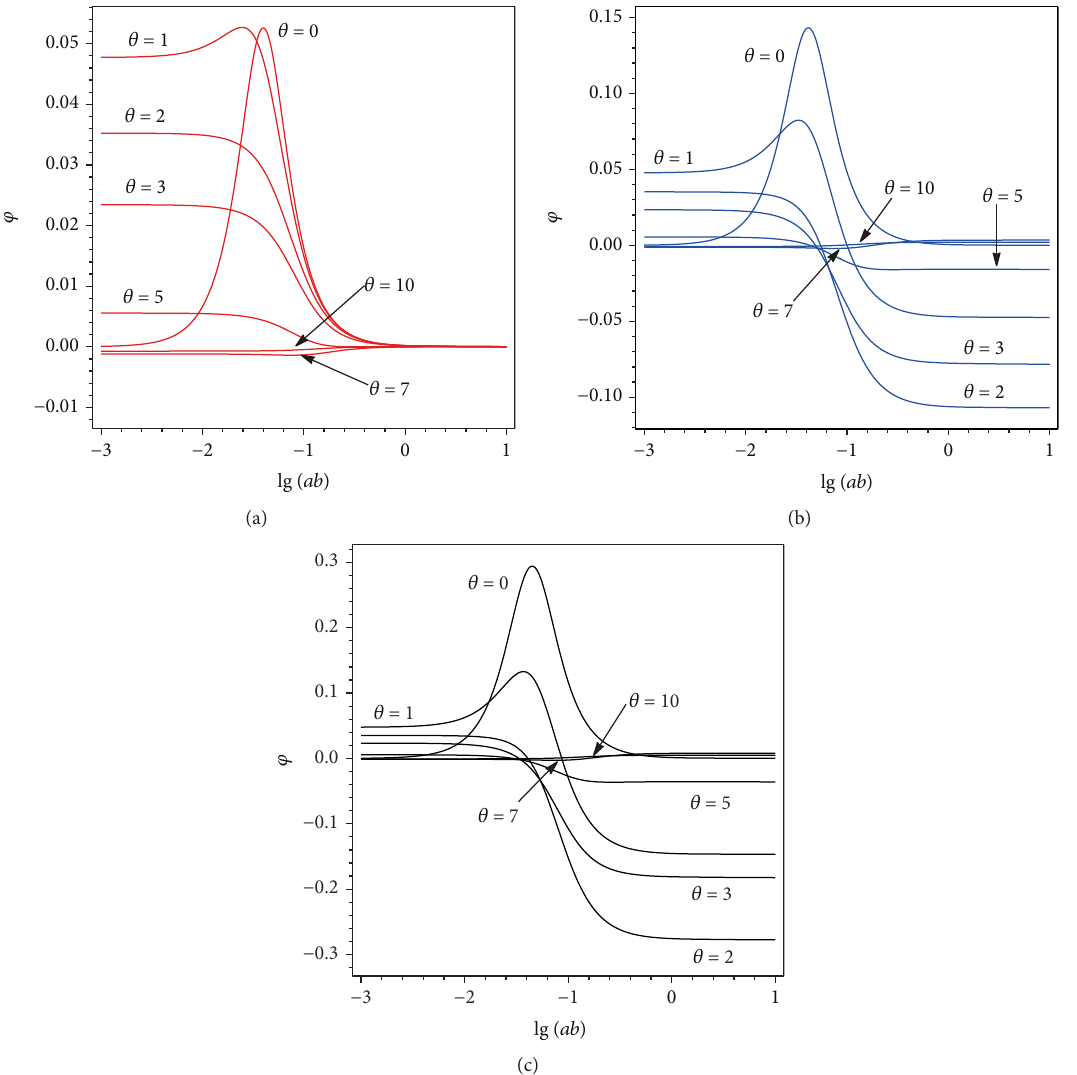
Figure 5: Changes of the phase shift φ at the middle of the seabed semipermeable layer z = b + 0 5 b ′ with lg ab for di ff erent values of θ when is equal to (a) 0.8, (b) 0.5, and (c) 0.1. The loading coe ffi cient L L e 1